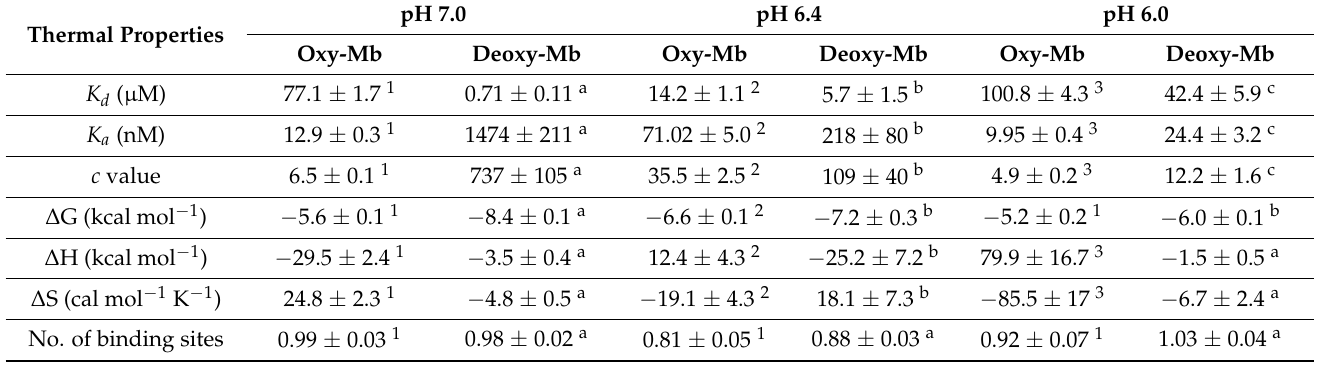
Table 1. Binding thermodynamics of pyruvate (PYR) titrated against equine oxy-Mb and deoxy- Mb in ITC experiments at different pH conditions. Dissociation constant ( K d ), association constant ( K a ), Gibbs free energy ( ∆ G), change in enthalpy ( ∆ H), change in entropy ( ∆ S), and the accuracy of curve fitting to obtain K d and binding stoichiometry ( c -value) are shown in the table. All the ITC experiments were repeated 3 times ( n = 3) to obtain the thermodynamic properties. Statistical analysis was performed using one-way ANOVA for each parameter, within oxy-Mb or deoxy-Mb at each pH condition, and the values presented as means ± SEM. Numerical and alphabetical data in the superscript represent statistical significance ( p -value < 0.05) among the test pH conditions for oxy- and deoxy-Mb, respectively.